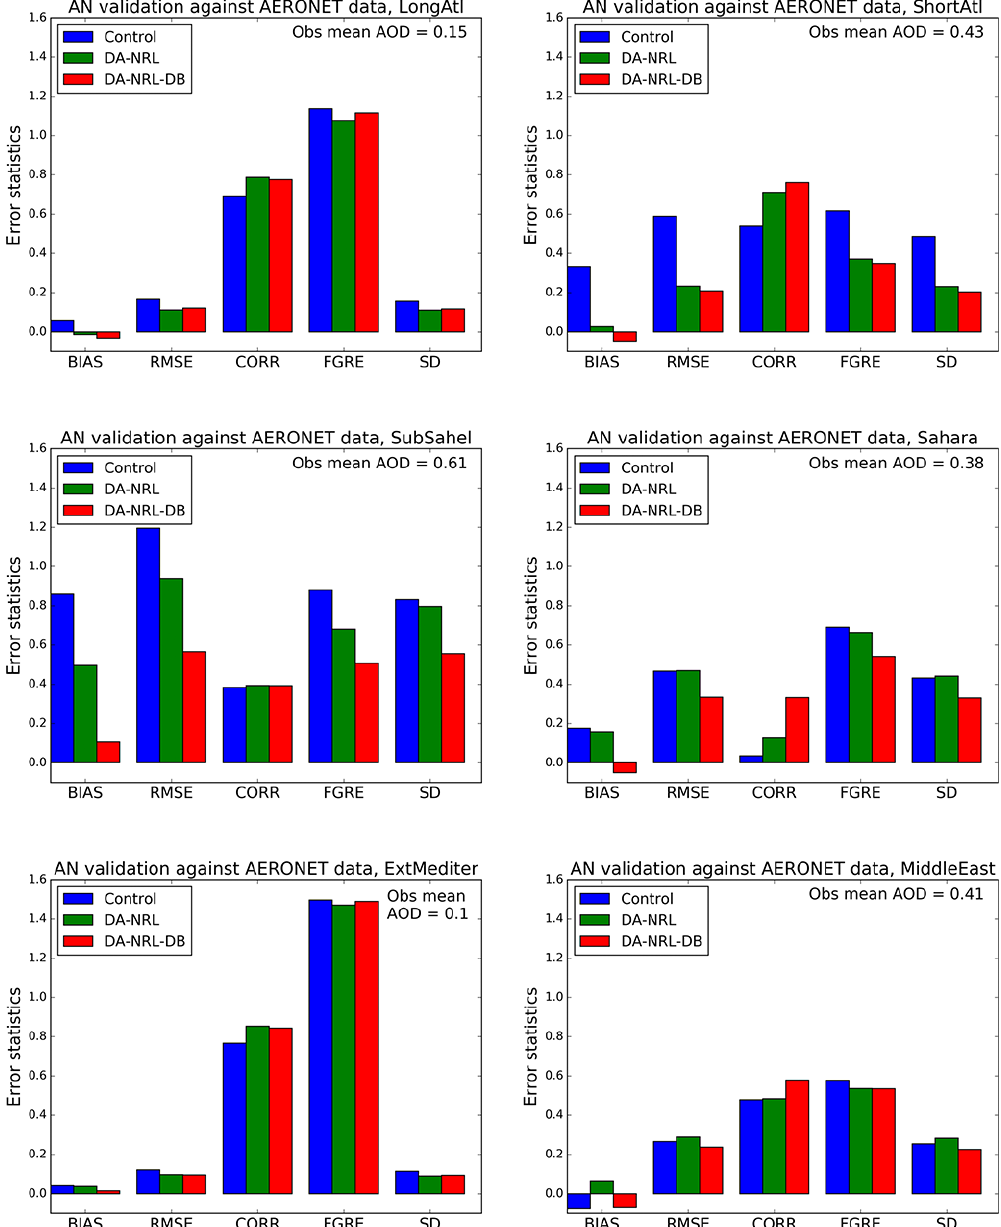
Figure 14. BIAS, RMSE, CORR, FRGE, and SD for the Control experiment, the DA-NRL experiments, and the DA-NRL-DB experi- ment calculated against AERONET observations for groups of stations within the regional domains in Fig. 5. The dust mean AOD for the observations used for validation during the experiment period is also